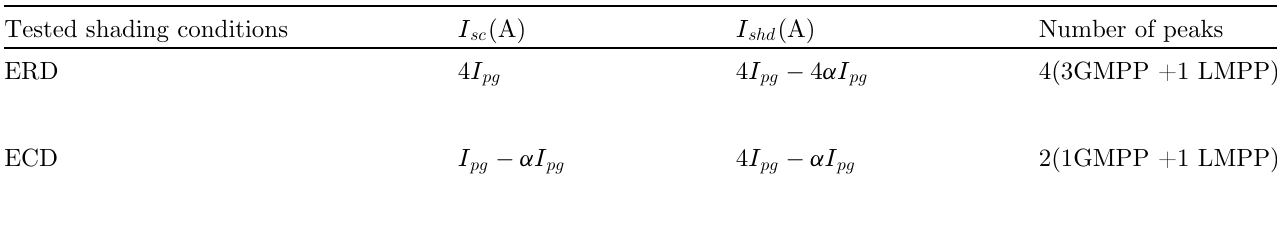
Table 2. Numerical analysis summary of HCTCT con fi guration under ERD and ECD shading patterns. Tested shading